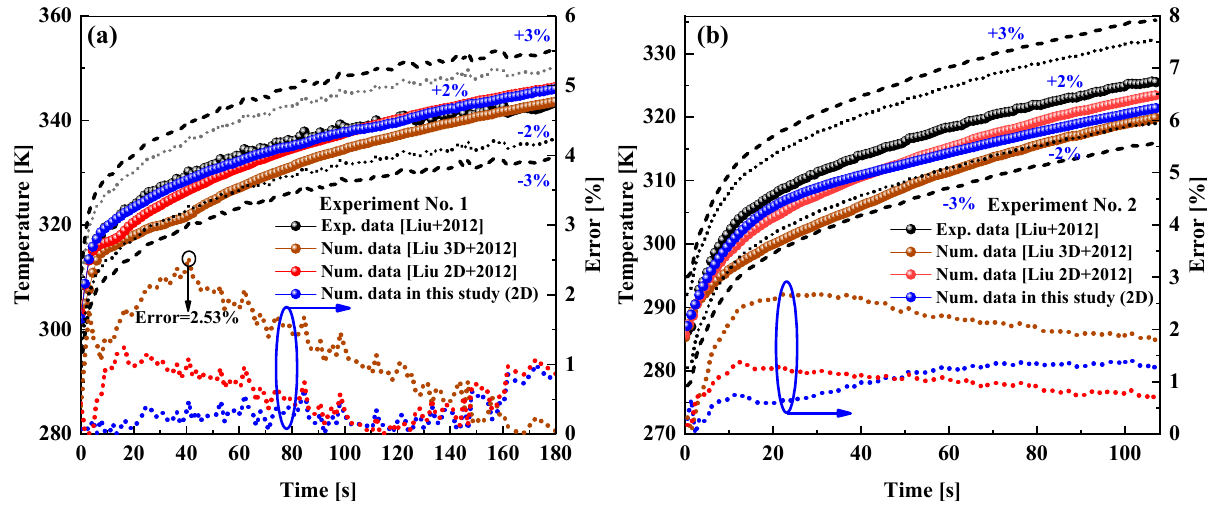
Figure 4. Results of the mean temperature for experiment No. 1 (a) and experiment No. 2 (b) [Liu, 2017].